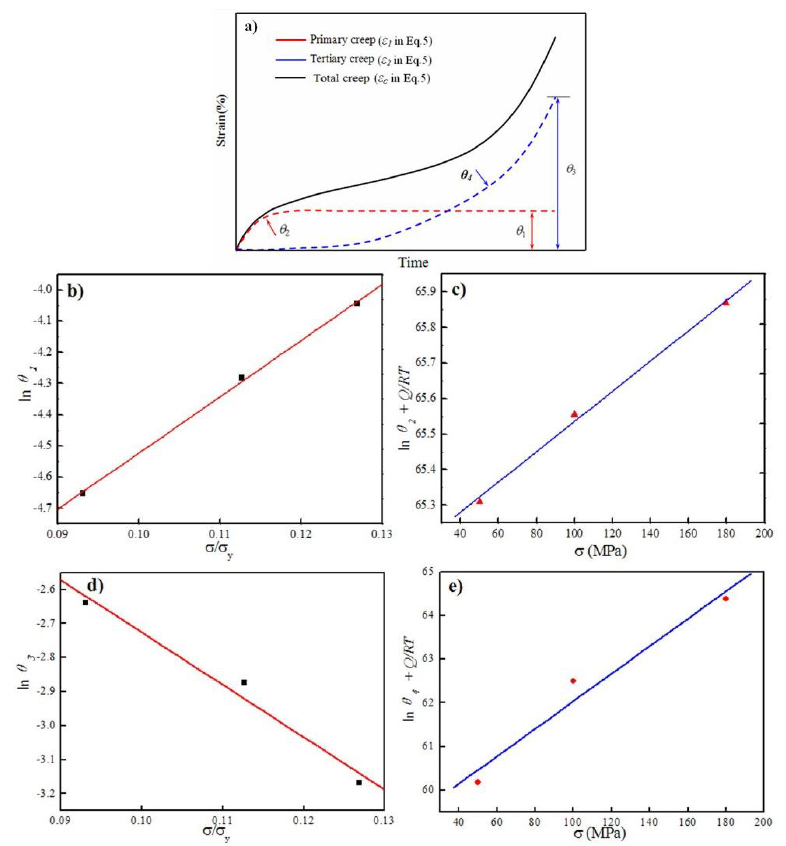
Figure 5. ( a ) Schematic creep curve based on the θ projection concept. Relationships of ( b ) lnθ 1 − σ/σ y ; ( c ) (lnθ 2 + Q /R T ) − σ; ( d ) lnθ 3 − σ/σ y and ( e ) (lnθ 4 + Q /R T ) − σ.